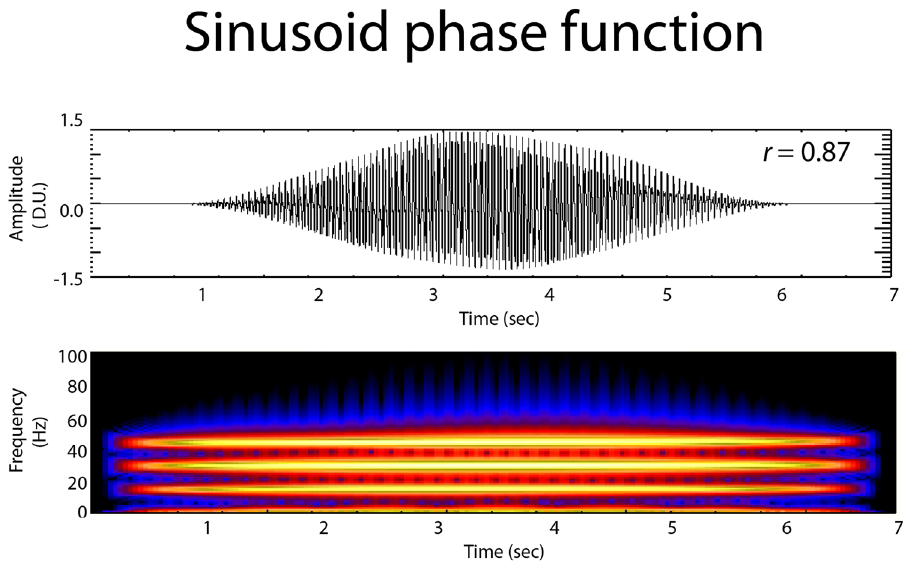
Figure 6. Example of a sinusoidal based blue whale B call model. The model here is a sine function summation, but with a variable phase term introduced (eq. 3) to better improve the match of the width of individual waveforms 38 . The model was cross-correlated with an original B call, and resulting r is